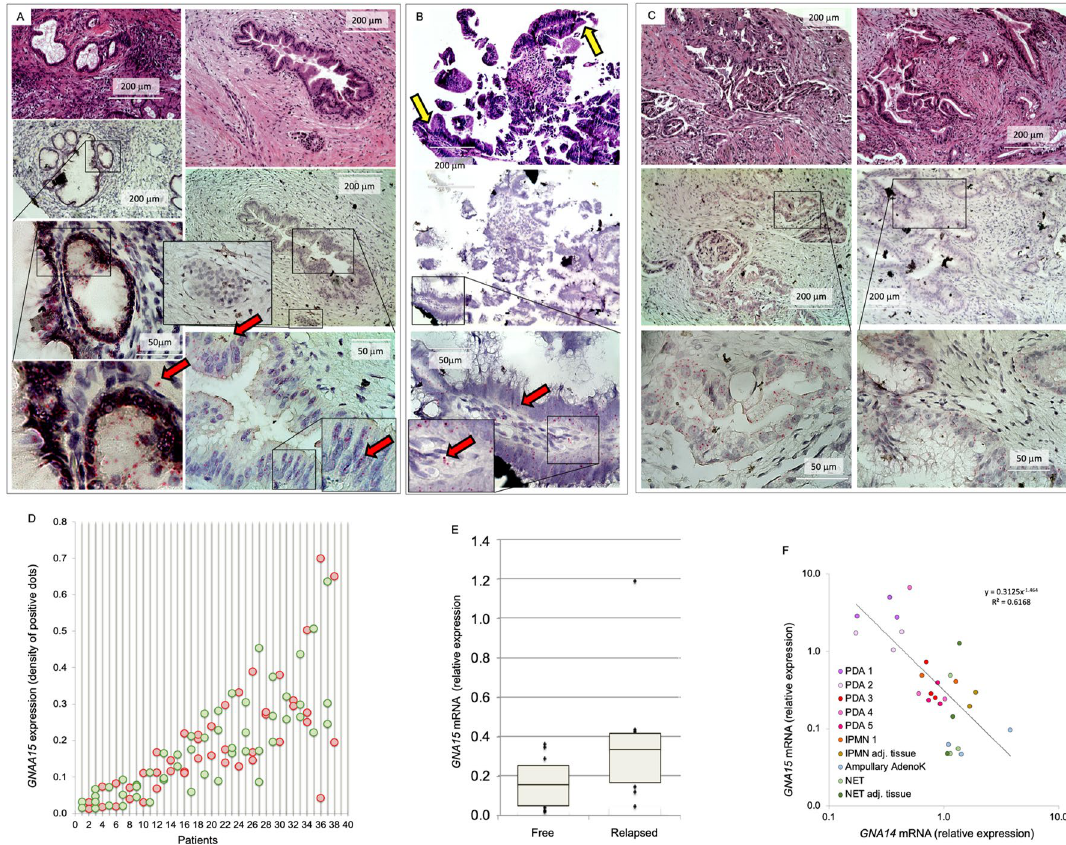
Figure 4. de novo GNA15 gene expression in PDAC. ( A–C ) Human pancreas biopsies were analyzed by eosin hematoxylin (upper panels) or ISH (middle and lower panels) developed in Fast-RED (two examples are indicated by the red arrows) utilizing a GNA15 specific probe in addition to positive and negative controls (Supp. Fig. S1). Preneoplastic and neoplastic lesions were evidently positive. A PanIN1 lesion is shown in panel A (left micrograph), and a PanIN2 (right micrograph). A superficial fragment of an IPMN is shown in panel B, the yellow arrows indicate papillary structures in the non invasive region. Panel C shows two examples of PDAC. ( D ) The expression level of GNA15 was quantified by ISH. In the abscissa each number corresponds to a patient, and each circle represents the average value (dot density by ISH) of all lesions in a FFPE section, one circle per section, 2–4 sections per patient, 37 total patients. Red or green dots were used alternatively to differentiate each patient. ( E ) GNA15 relative expression in the primary tumor was quantified by ISH and compared in patients that relapsed versus patients that remained disease free one year after pancreas resection. Box plots are shown as median and 25th and 75th percentiles: points are displayed as outliers if they are above or below the 1.5 times the interquartile range. A T-test was applied to compare the two groups, p < 0.05. ( F ) Tumor tissue fragments of resected pancreata were split in two parts. Half was analyzed by ISH to select for variable GNA15 expression levels going from absent (apparently healthy tissue from NET patients) to high (PDAC with abundant positive lesions). The other half of the fragment was analyzed by TaqMan RT-PCR measuring GNA15 and GNA14 expression